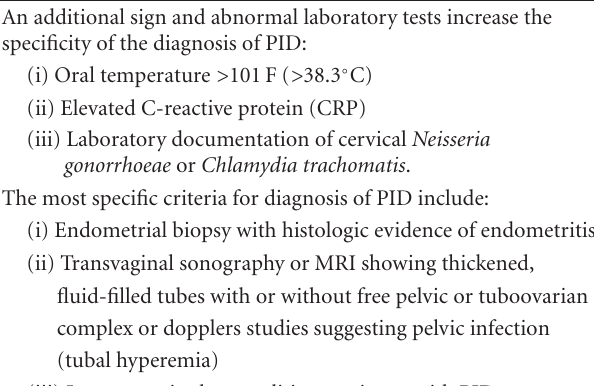
Table 2: Signs and tests to increase the specificity of a diagnosis of